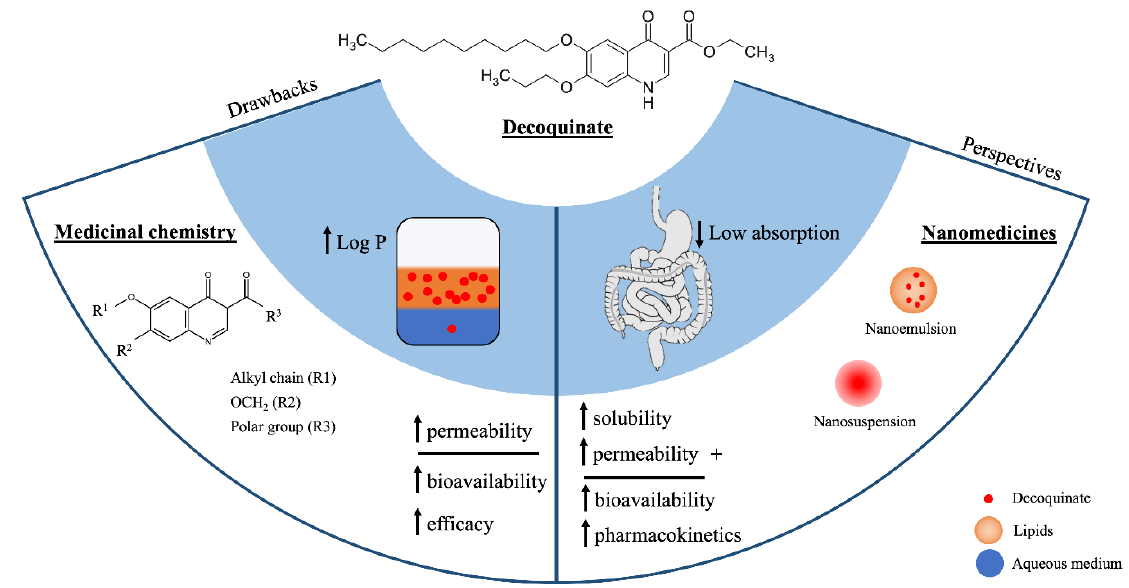
Figure 6. Drawbacks of and perspectives on decoquinate research.